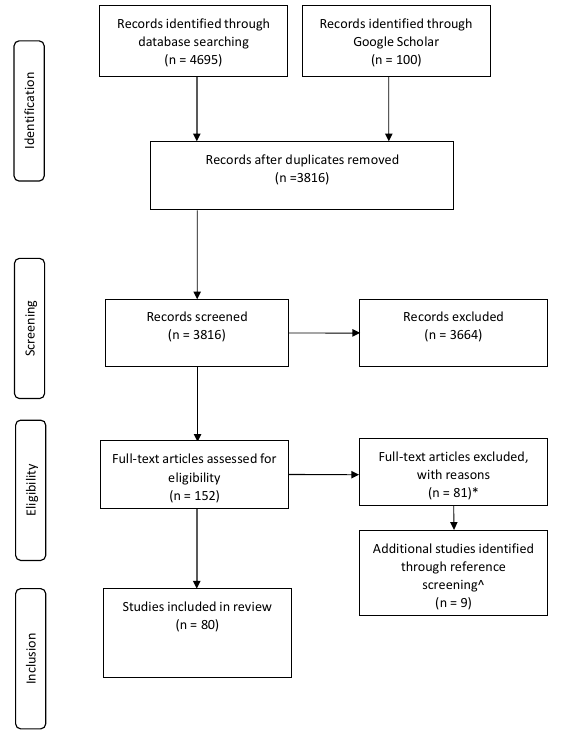
Figure 1. PRISMA flow diagram. *Of the 152 articles reviewed, N=54 were excluded as the wrong study type, N=12 were exclude as they did not include studies of employees, N=10 were excluded as they were the incorrect interven- tion type, N=5 were excluded as they did not include the outcome of interest. ^N=9 studies were included after full text review, after screening reference lists of N=4 reviews of